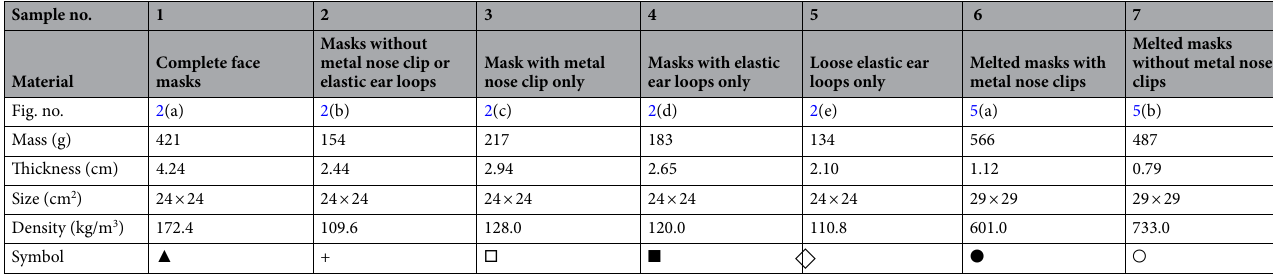
Table 1. Physical properties of the tested samples.